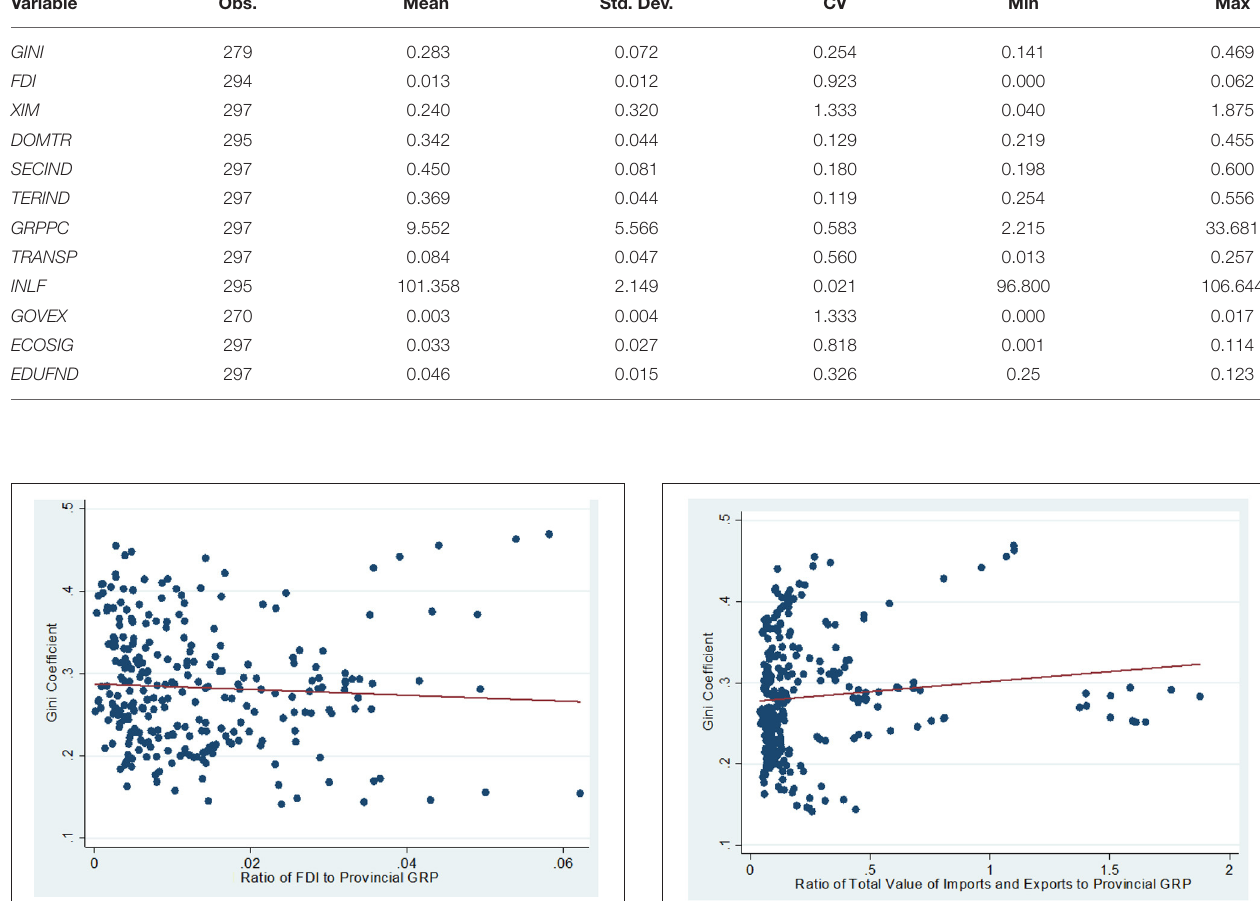
TABLE 1 | Descriptive statistics. Variable